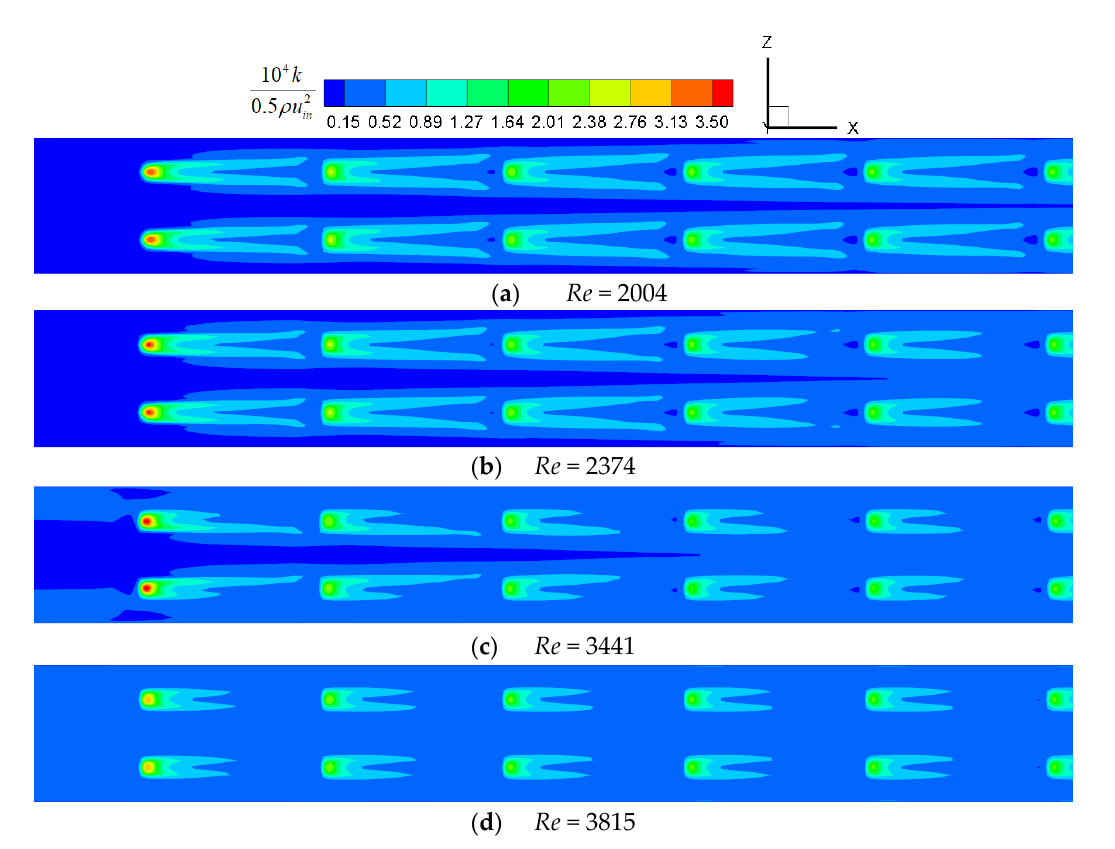
Figure 23. Nondimensional turbulent kinetic energy contours on the middle cross section.